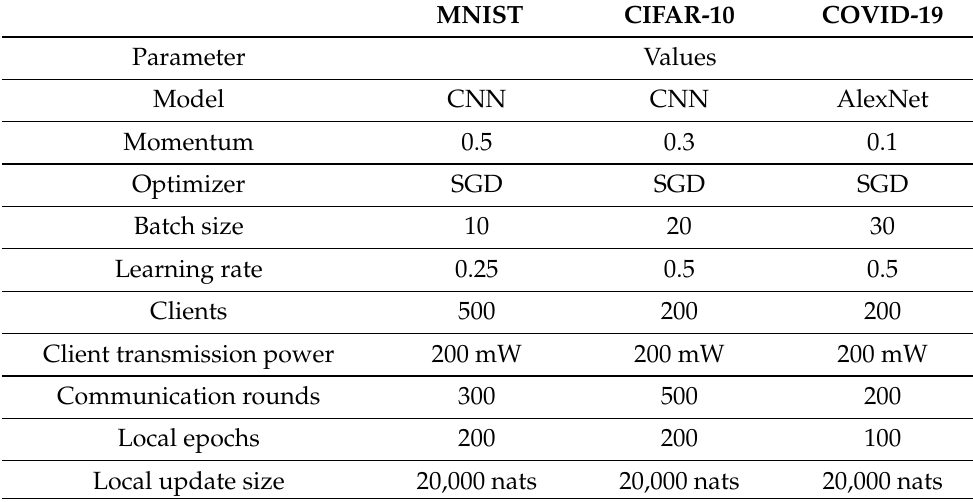
Table 2. Hyperparameters used in the proposed experiments.